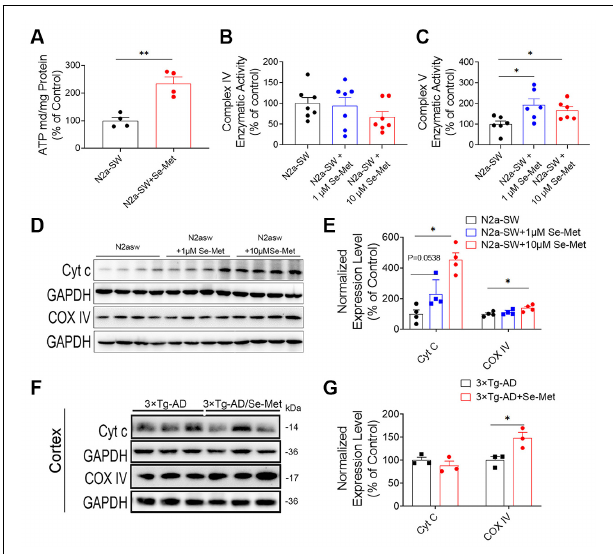
FIGURE 5 | Se-Met increased ATP levels by promoting ATP synthesis. (A) ATP levels in the N2a-SW cell line treated with 10 µ M Se-Met ( ∗∗ p < 0.01 vs. the control group, n = 4). (B,C) The enzymatic activity of complex IV (B) and complex V (C) was detected with a Micro Mitochondrial Respiratory Chain Activity Assay Kit ( ∗ p < 0.05 vs. the control group, n = 6). (D–F) The expression levels of Cyt c and complex IV in N2a-SW cells (D) and in the cortices of AD mice (F) were detected by western blot analysis. (E–G) Quantitative analysis of the expression levels of Cyt c and complex IV ( ∗ p < 0.05 vs. the control group. n = 4; ∗ p < 0.05 vs. AD mice, n = 3